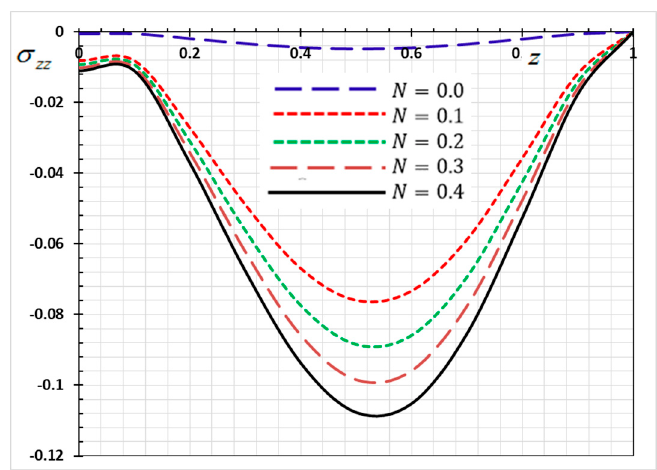
Figure 12. Variation of electric potential 𝜑 versus 𝑧 for different gradient coefficient 𝑁 .